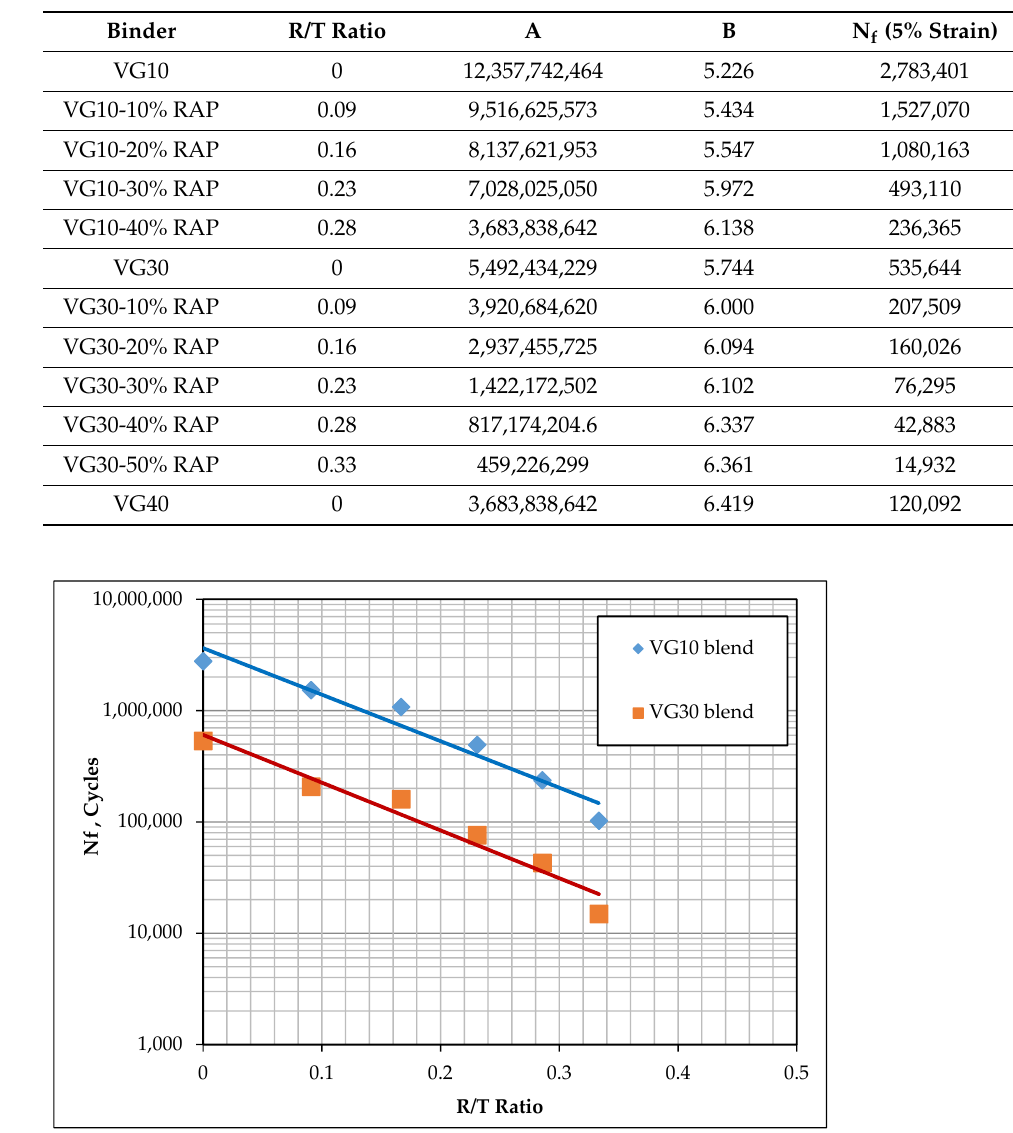
Table 9. LAS Fatigue Model Parameters.